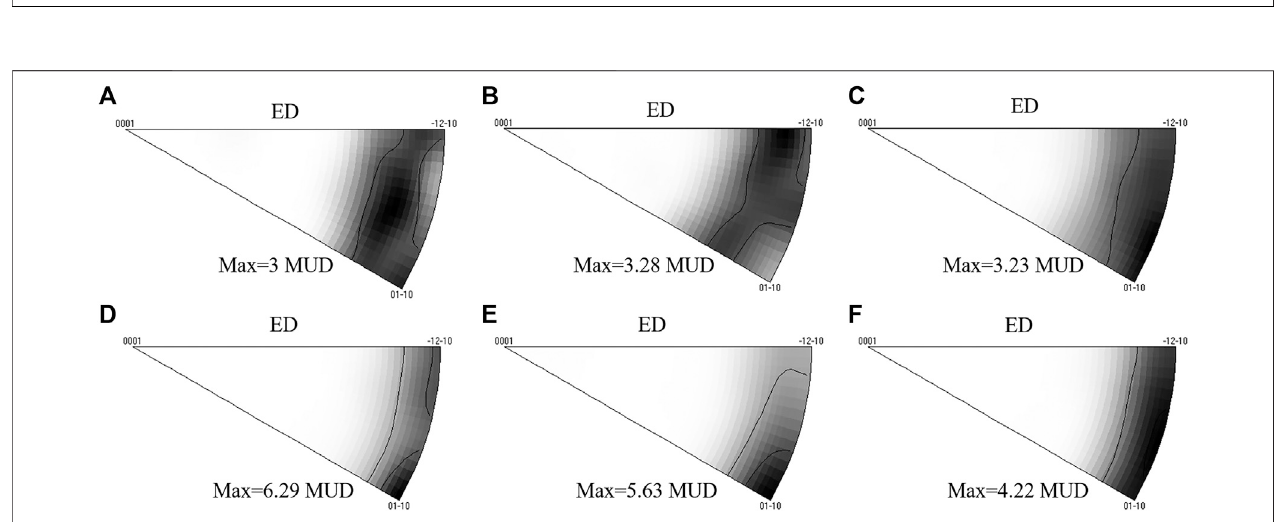
Figure 11 . The typical brittle fracture featured with the cleavage plane is observed in pure Mg and Mg-1Bi. Both dimple-like failure and low ductility cleavage plane are observed in Mg-3Bi, Mg-6Bi, and Mg-9Bi. The Mg-9Bi-